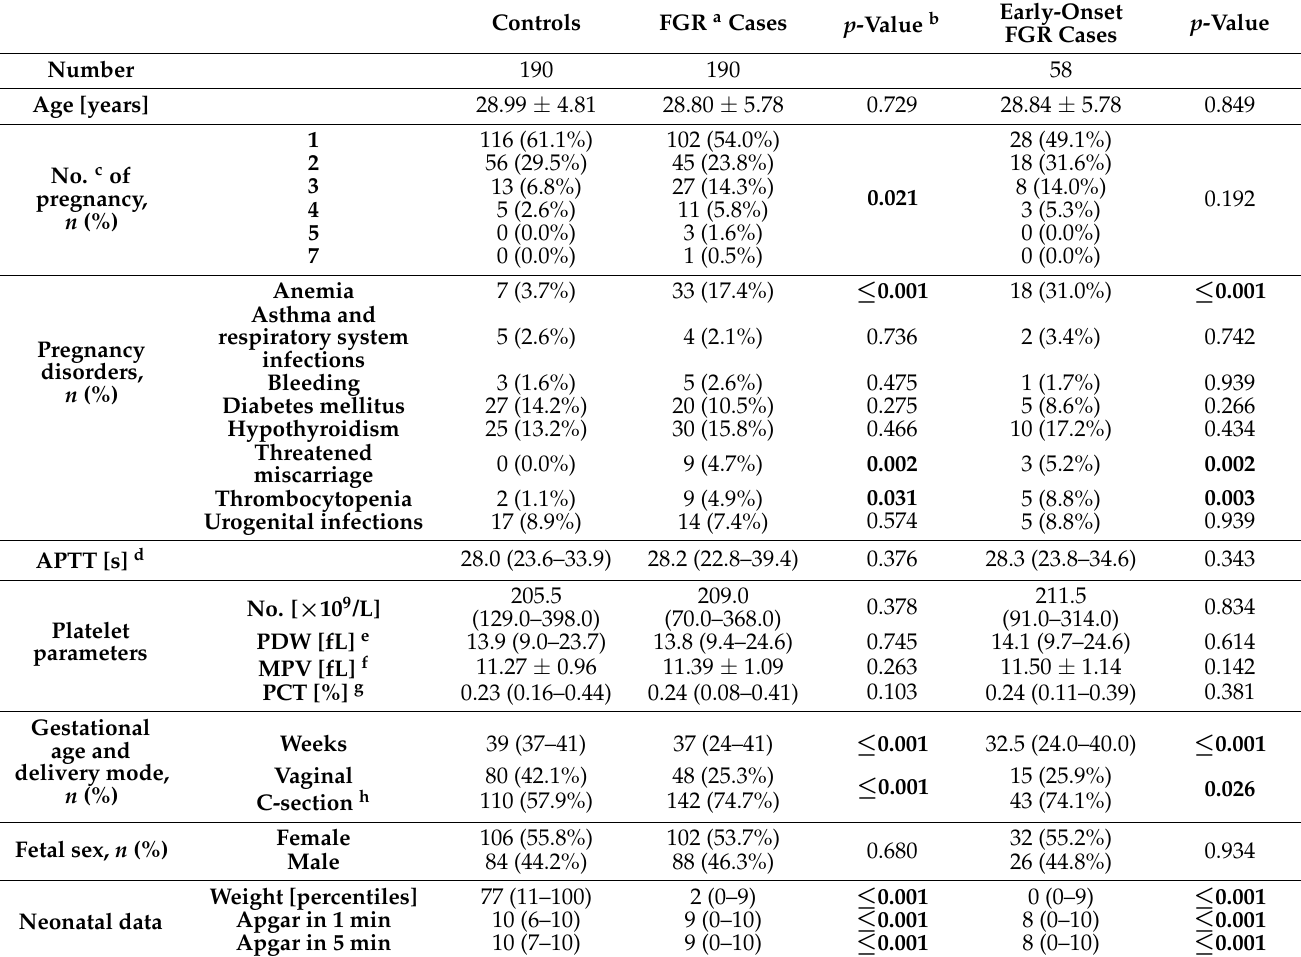
Table 1. Characteristics of women with fetal growth restriction and healthy